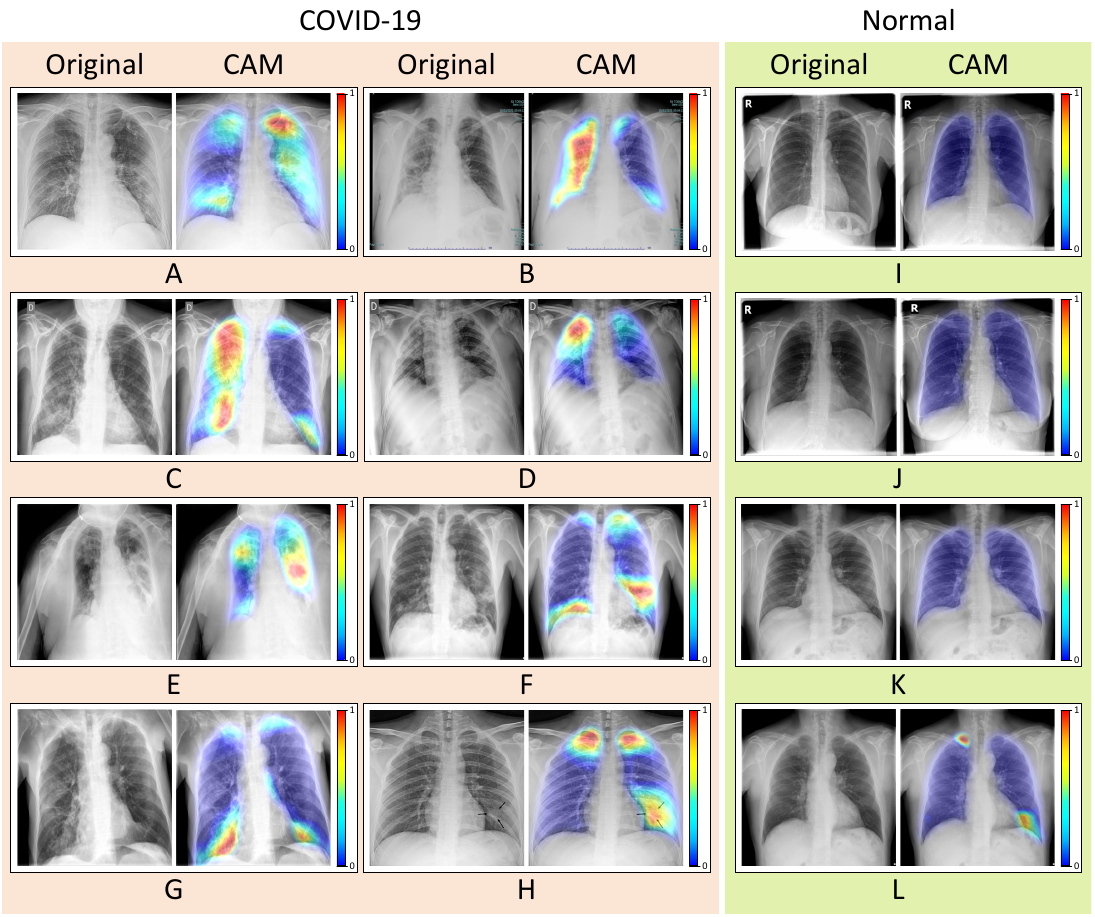
Figure 4. CAMs obtained for the COVID-19 class together with their corresponding original images. Images ( A – H ) represent COVID-19 cases, while ( I – L ) correspond to healthy patients. CAMs are represented with heatmaps, where the most relevant regions for COVID-19 detection are highlighted in